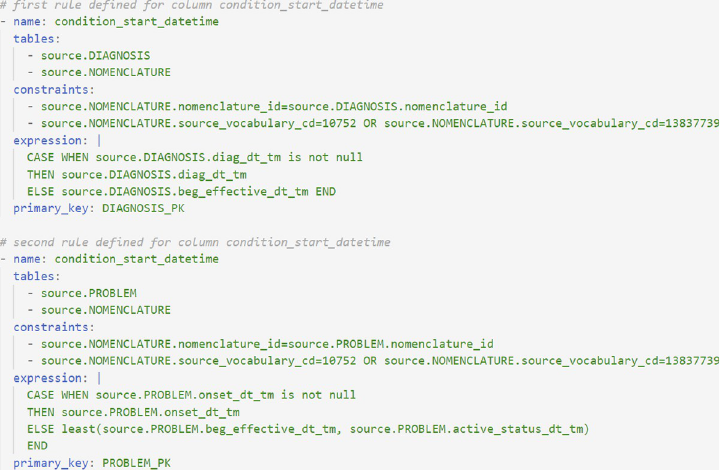
Fig 5. Example of complex mapping rules. Two rules are used to map diagnosis records and problem records from multiple source tables to the condition_start_date field in the OMOP CONDITION_OCCURRENCE table. Multiple rules can be written to map source data to a single OMOP column, dividing complex logic into queries that are easier to read and debug.